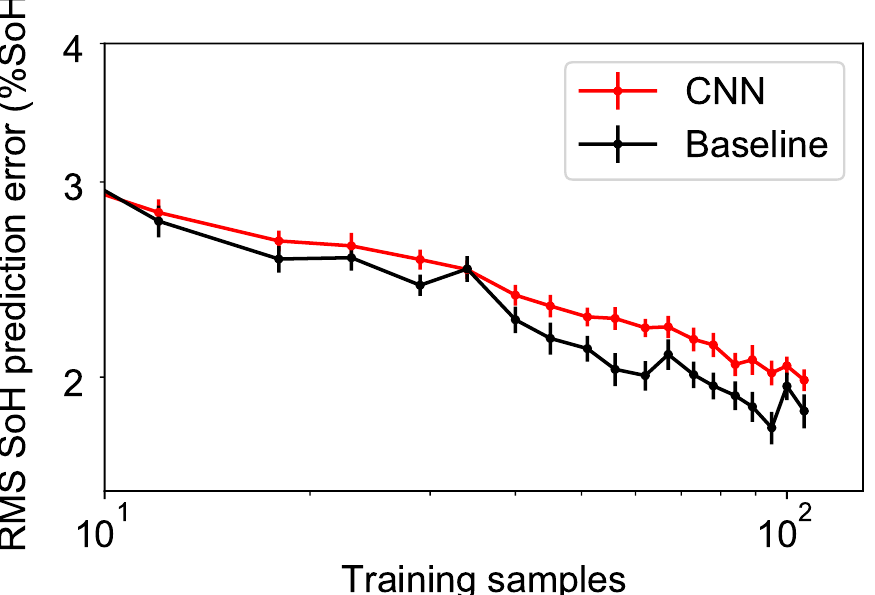
Figure 5. Sample efficiency plot of 6-fold cross-validated RMS state of health prediction error for the model-based baseline and model-free